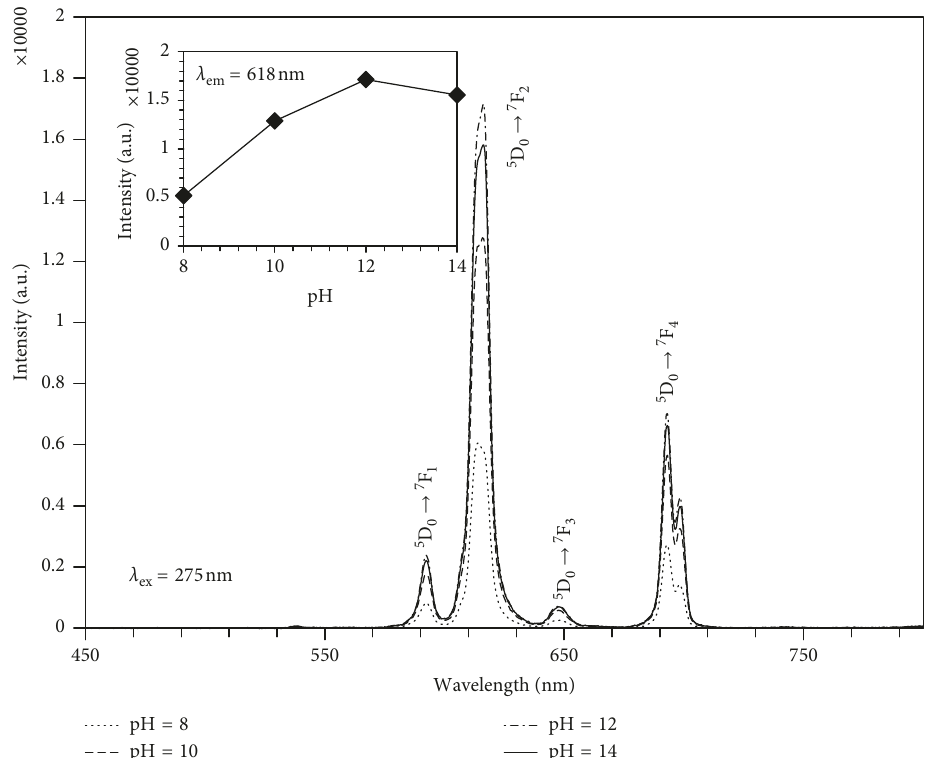
Figure 5: Photoluminescence spectra of samples with different pH values. Inset shows pH value dependence on 5 D